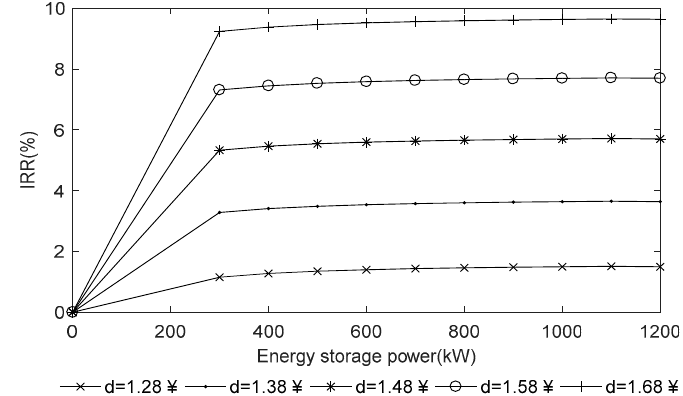
Figure 14. IRR index of users participating in load shaving service under different energy storage costs.